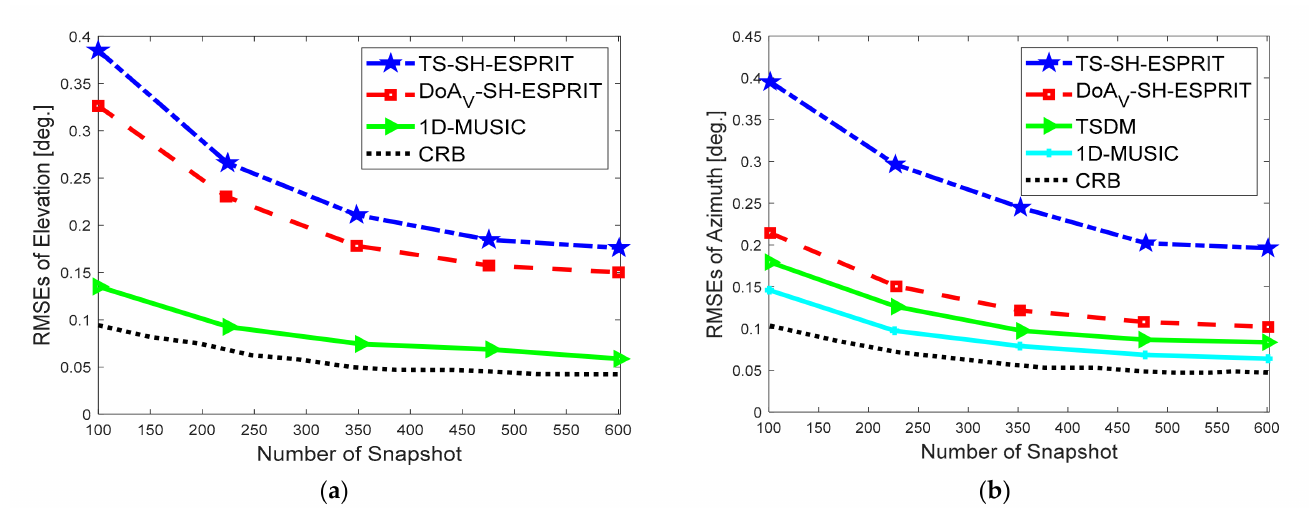
Figure 6. RMSEs estimation versus number of snapshot with two sources. ( a ) Elevation ( b ) Azimuth.